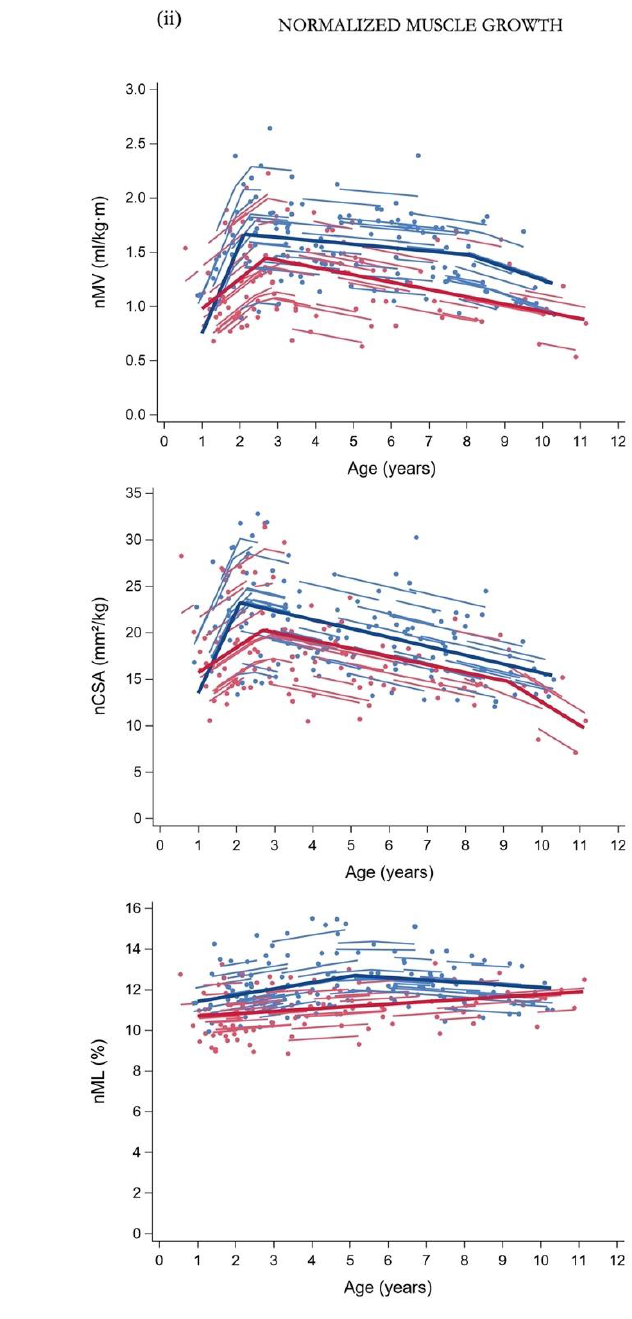
Figure 2. Predicted average trajectories (bold solid line) for the ( i ) absolute and ( ii ) normalized muscle morphology in SCP children with GMFCS level I (blue) and GMFCS level II–III (red). Observed outcomes (dots) and individual predicted trajectories (lines) are presented. SCP, spastic cerebral palsy; GMFCS, gross motor function classification system; MV, muscle volume; ml, milliliter; CSA, anatomical cross-sectional area; mm, millimeter; ML, muscle belly length; n, normalized; kg, kilogram; m,